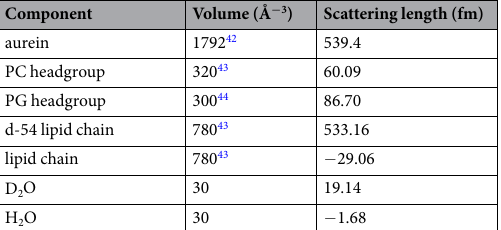
Table 2. Volumes and neutron scattering lengths of the components. Neutron scattering lengths are calculated from Sears 45